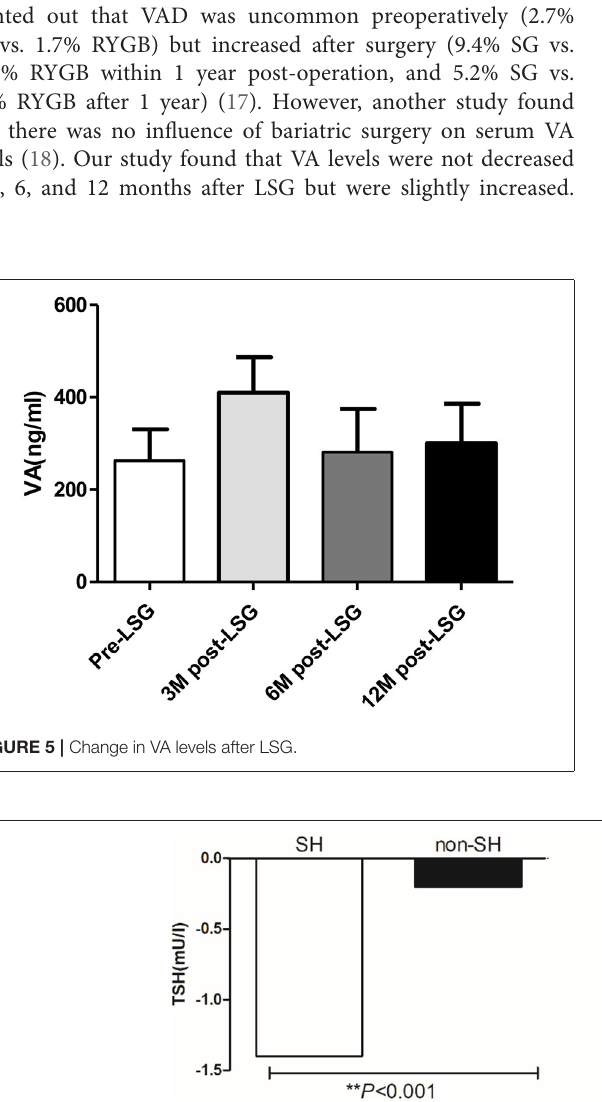
Frontiers in Nutrition |